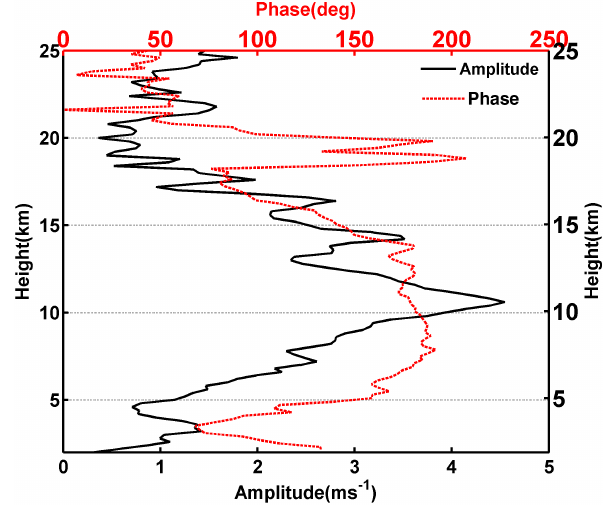
Figure 2. Height profiles of amplitude (ms − 1 ) and phase (deg) of Rossby waves (period ∼ 8 days) in zonal winds observed by ra- diosonde measurements between 1 November and 31 December